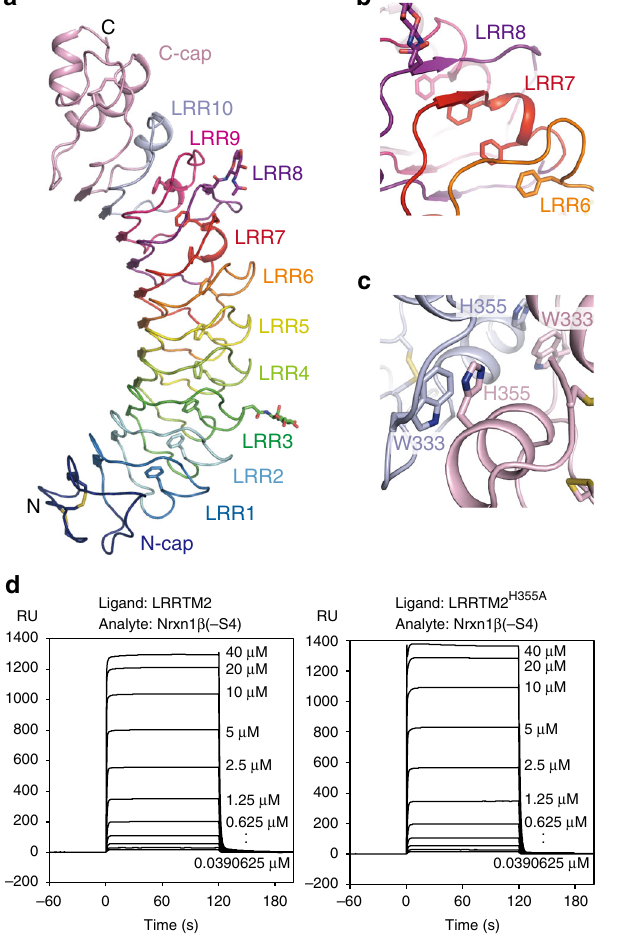
coordinated by the side chains of Asp141 and Asn212 and the main chains of Val158 and Ile210 in Nrxn1 β (residue numbering is based on human Nrxn1 β ( – S4); Fig. 2b). Although the side chain of LRRTM2 Glu348 is 3.8 Å apart from the calcium ion, a residual density that could be assigned as a coordinated water molecule was observed between them. We thus modeled a water molecule in the density. The B -factor value of this water molecule (59.8 Å 2 ; averaged over four molecules in the asymmetric unit; Table 1) is comparable to those of its surrounding residues, indicating that the modeling of this coordinated water molecule is reasonable. Therefore, we concluded that LRRTM2 Glu348 interacts with the calcium ion via the coordinated water molecule (Fig. 2b). The comparison between the apo-LRRTM2 T59L and Nrxn1 β -bound LRRTM2 H355A structures (rmsd of 0.42 Å for C α atoms) indicates that no drastic conformational change of LRRTM2 occurs upon binding to Nrxn1 β , except that the side chain of LRRTM2 Glu348 fl ips towards the coordinated Ca 2 + (Fig. 2c). The Ca 2 + -mediated interaction between Nrxn1 β and LRRTM2 was assessed by SPR analysis of the LRRTM2 E348Q and Nrxn1 β D141A mutants (Fig. 2d). The LRRTM2 E348Q and Nrxn1 β D141A mutations completely and almost completely abolished the binding to Nrxn1 β and LRRTM2, respectively (Fig. 2d). These fi ndings indicate that the Ca 2 + -mediated inter- action is critical for the binding between Nrxn1 β and LRRTM2. Apart from the Ca 2 + -mediated interaction, a hydrogen bond is formed between Nrxn1 β Arg206 and LRRTM2 Asp352. The D352A mutation of LRRTM2 decreased the af fi nity by >9-fold (Fig. 2d), whereas the R206A mutation of Nrxn1 β decreased it by >40-fold (Fig. 2d). The Nrxn1 β – LRRTM2 interface also involves hydrophobic interactions. Phe357 of LRRTM2 hydrophobically interacts with Leu208 of Nrxn1 β . Both the LRRTM2 F357A and Nrxn1 β L208A mutations decreased the af fi nities to unmeasurable levels (Fig. 2d). Ala355 of LRRTM2 H355A ,